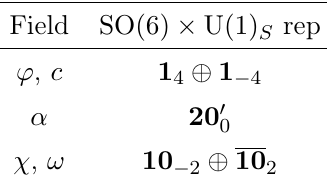
Table 2. The scalar truncation of the maximal supergravity in five dimensions relevant for the holographic dual to the N = 4